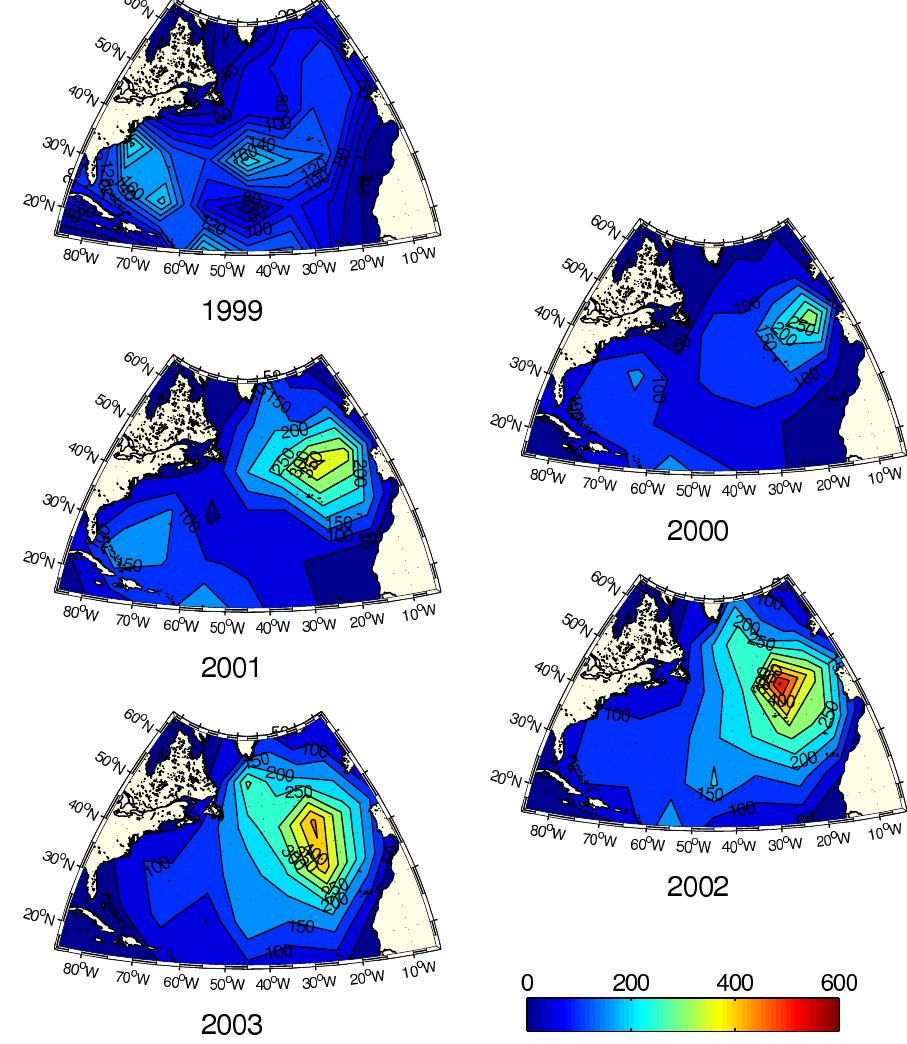
Fig. 1. The number of profiles in the 10 ◦ boxes for each year (1999–2003) after the quality control was